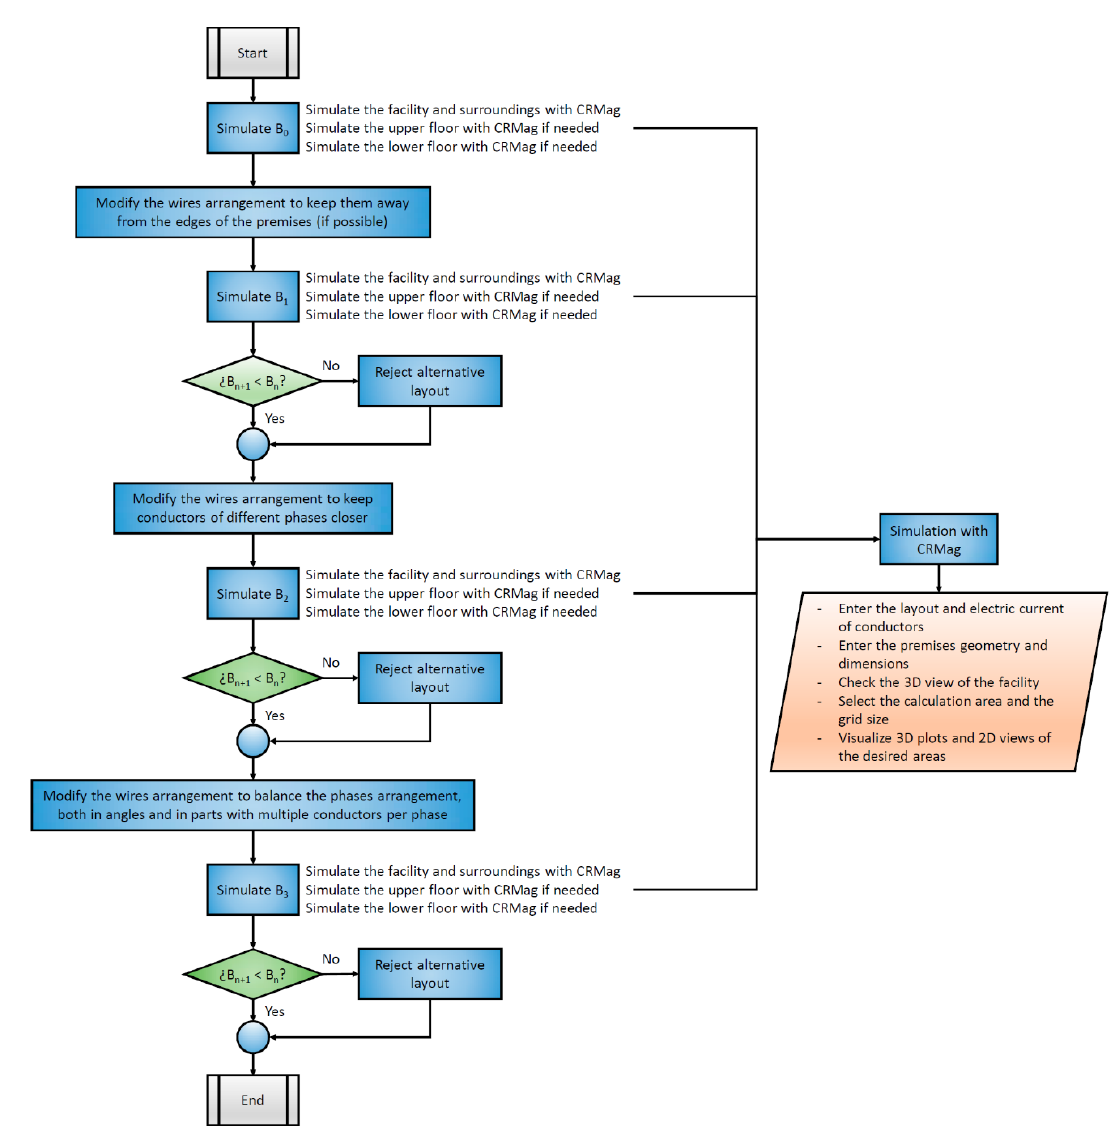
Figure 8. Proposed method to study and minimize the immission in the surroundings of an electrical